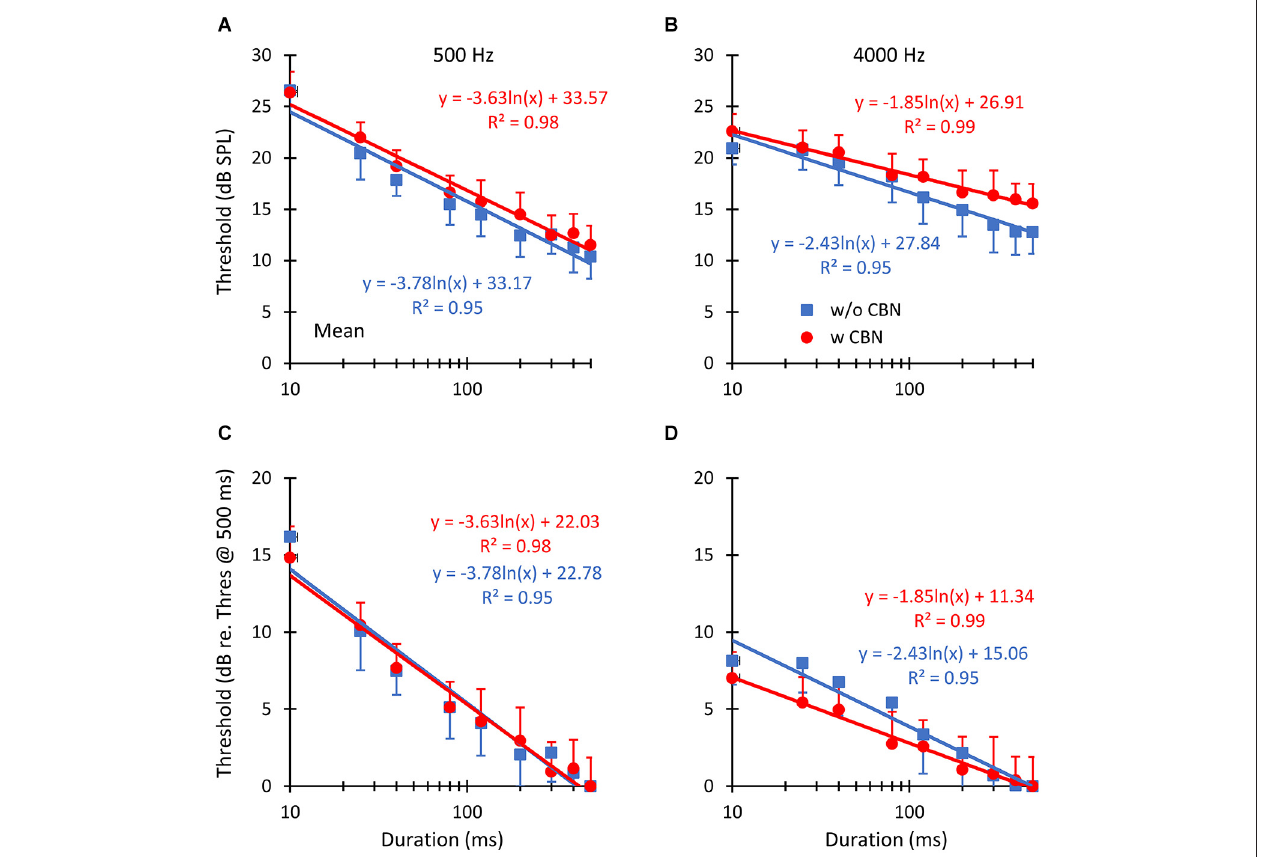
of a CBN, as indicated by the inset in panel B. Error bars illustrate one standard error of the mean. Lines illustrate least-squares fits to the data using the logarithmic functions given next to the data. The two rows show identical data in units of dB SPL (A,B) or dB re threshold for the 500-ms tone (C,D)